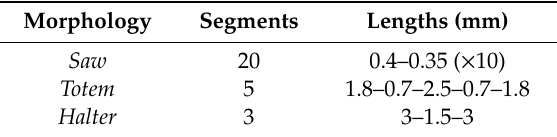
Table 1. Inflatable cavities segments lengths.